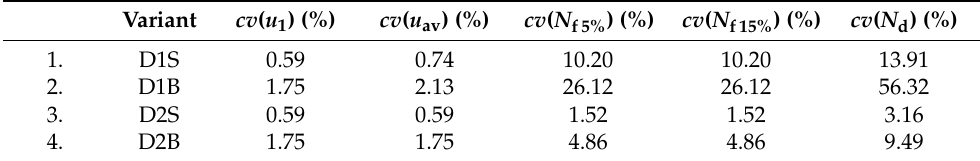
Table 4. Variation coefficient of deflection values and design